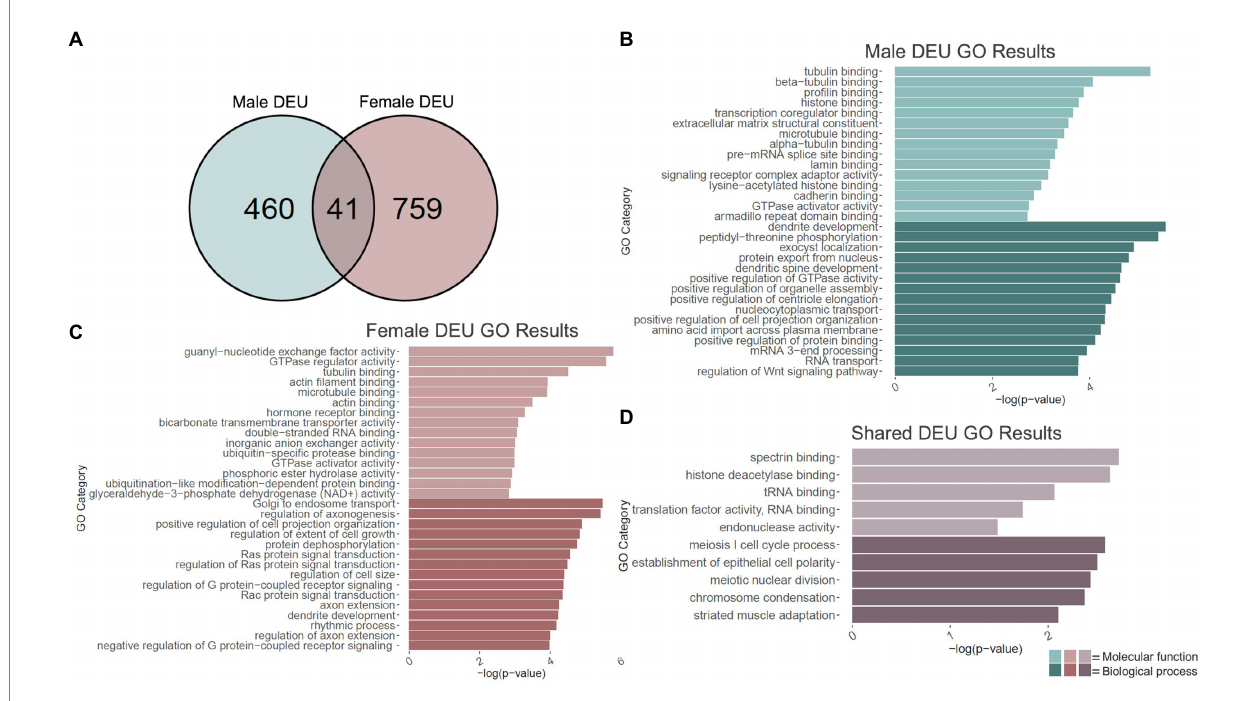
FIGURE 3 GO analysis of differential exon use (DEU) genes. (A) Number of genes showing differential exon use due to adolescent binge ethanol in males and females at p < 0.001. Fisher’s exact test determined male and female gene overlap to be significant, p = 1.7e-11. (B) GO analysis of genes with differentially used exons unique to males. (C) GO analysis of genes with differentially used exons unique to females. (D) GO analysis of genes with differentially used exons that are shared between males and